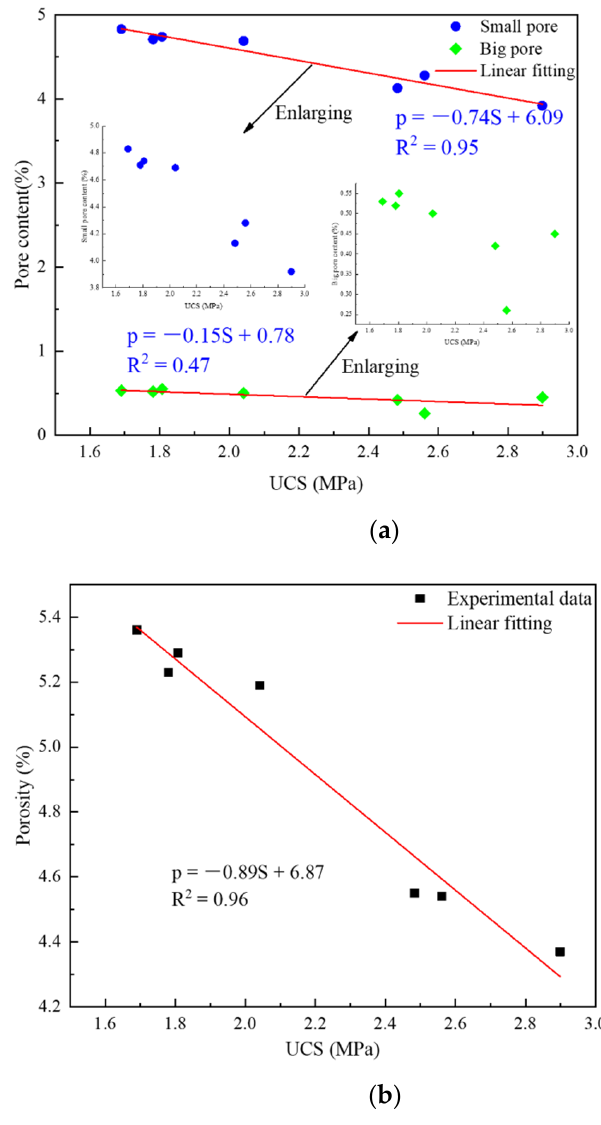
Figure 14. The relationship between UCS and pore content. ( a ): Relationship between UCS and small pore content ( b ): Relationship between UCS and porosity